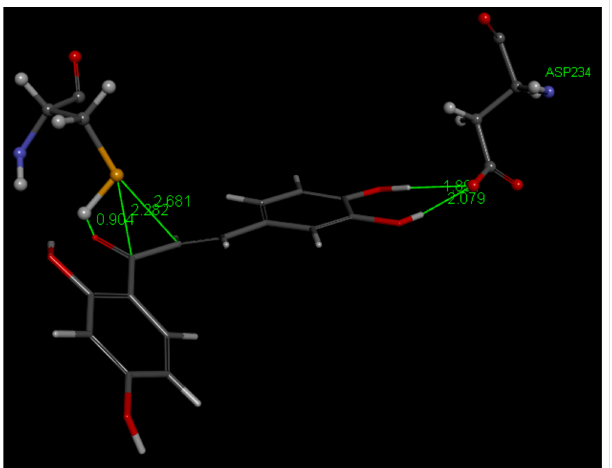
Figure 20. Butein ( 1 ) in the 3BPF receptor, pose 1, after calculating binding energies, − 17.7 kcal/mol. H[S(Cys42)] is captured by chalcone O(carbonyl). S(thiolate) is 2.282 Å from C(carbonyl), suggesting a covalent bond, whereas the ethenyl α carbon is more distant, 2.681 Å, and seems not suited for S(thiolate) nucleophicic attack. Adding stability to the Butein falcipain complex there are H bonds from the catechol moiety of ring B to Asp244, and chalcone O(carbonyl) to polypeptide HN(Trp43), omitted for clarity.